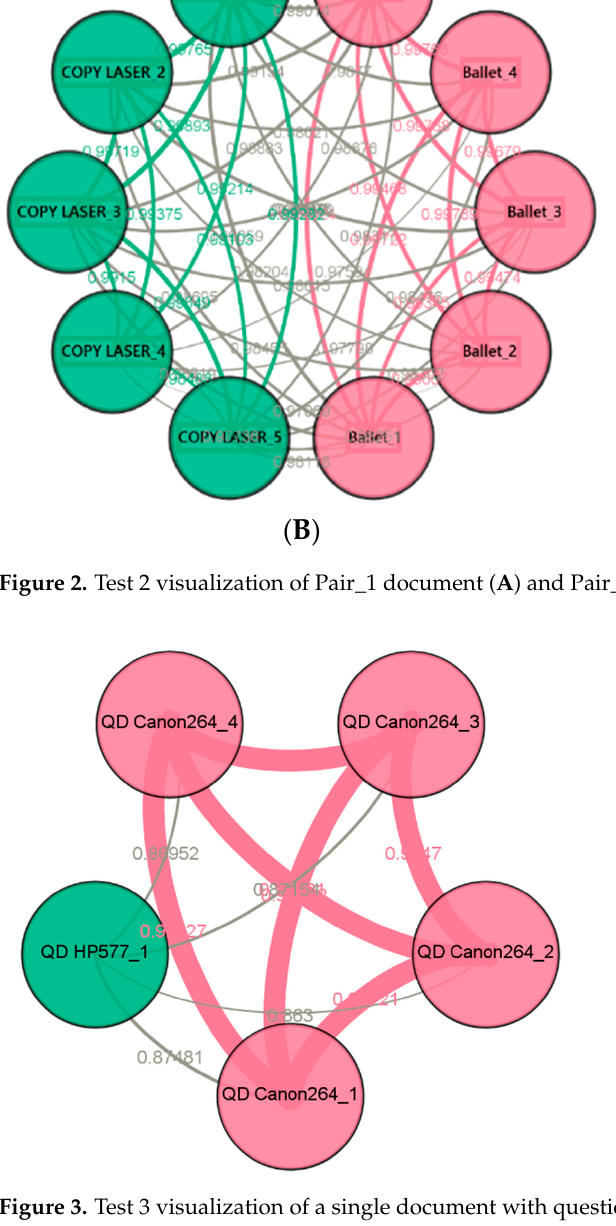
Figure 2. Test 2 visualization of Pair_1 document ( A ) and Pair_2 documents ( B ).